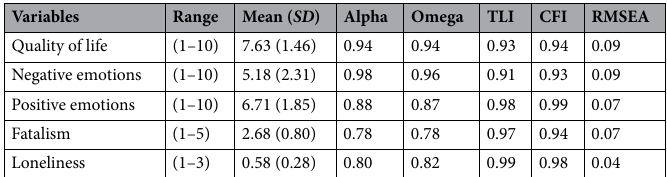
Table 1. Descriptive, validity and reliability analysis of study variables (N =